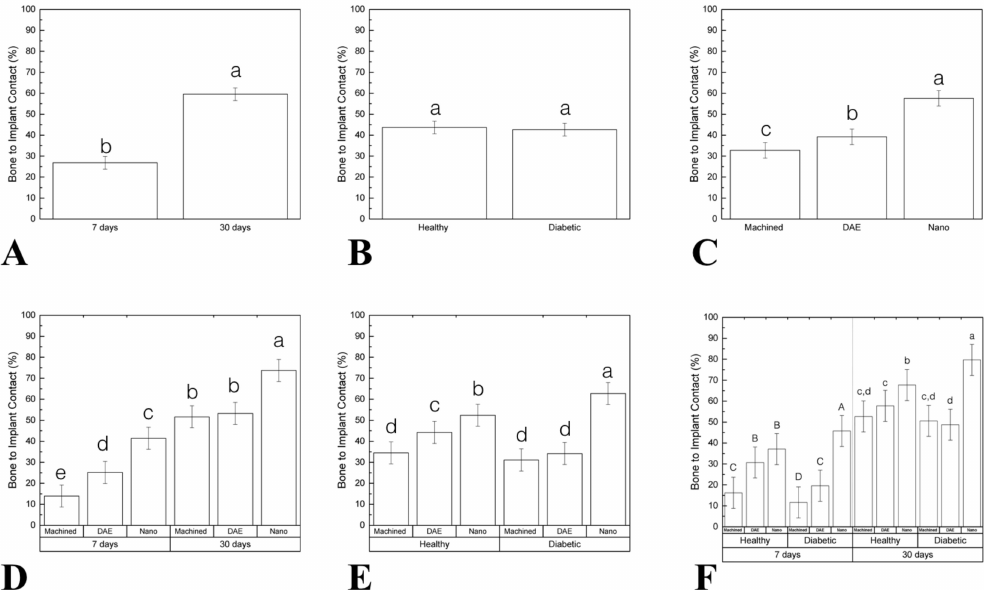
Figure 4. ( A – F ) Graphs representing the percentage of bone to implant contact (%BIC) di ff erently arranged as a function of study factors (mean and 95%CI). Significant di ff erence was seen between 7 and 30 days in vivo ( A ). No statistically significant di ff erences were found when comparing the healthy and diabetic group (data as function of systemic condition) ( B ). When implant surface was considered, NANO group exhibited higher %BIC relative to machined and DAE groups (data as a function of implant surface) ( C ). Data evaluation as a function of time and implant surface highlighted the superiority of the NANO group at 30 days compared to others ( D ). When %BIC was evaluated as a function of the systemic condition and surface, diabetic NANO group depicted a significant statistical di ff erence ( E ). Evaluating all factors: time, systemic condition, and surface treatment the results revealed that NANO surface presented the best results in the diabetic group (7 and 30 days) ( F ). Identical letters indicate no significant di ff erence among